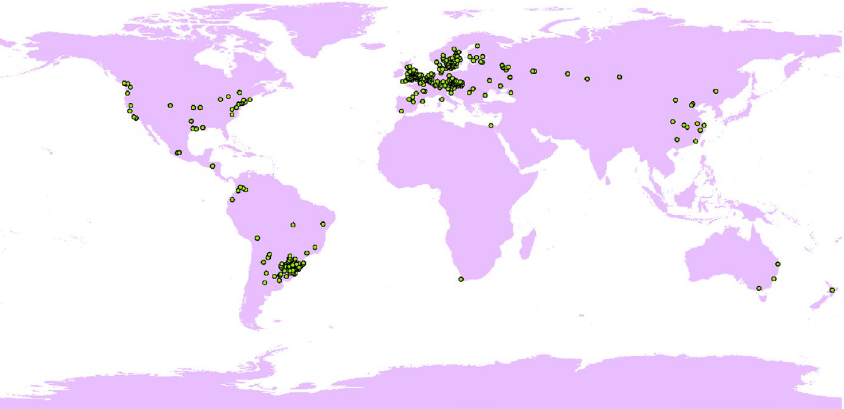
Figure 1. Global occurrence records used for the model simulation to predict the global potential suitable habitats of N.alata . This base map was directly obtained from the calculation of MaxEnt with the bioclimatic data from WorldClim. Global bioclimate data were acquired from the WorldClim open database (https:// world clim. org). The locations of species occurrence were collected from open databases: GBIF (http:// www. gbif. org), the Chinese Virtual Herbarium (CVH, https:// www. cvh. ac. cn/), the National Specimen Information Infrastructure (NSII, http:// nsii. org. cn/ 2017/ About Us. php), and Chinese Field Herbarium (CFH, https:// cfh. ac. cn/). The species distribution model was conducted with MaxEnt (Version 3.4.4, http:// biodi versi tyinf ormat ics. amnh. org/ open_ source/ maxent/), and results were modified with ArcGIS (version 10.7, https:// www. arcgis.